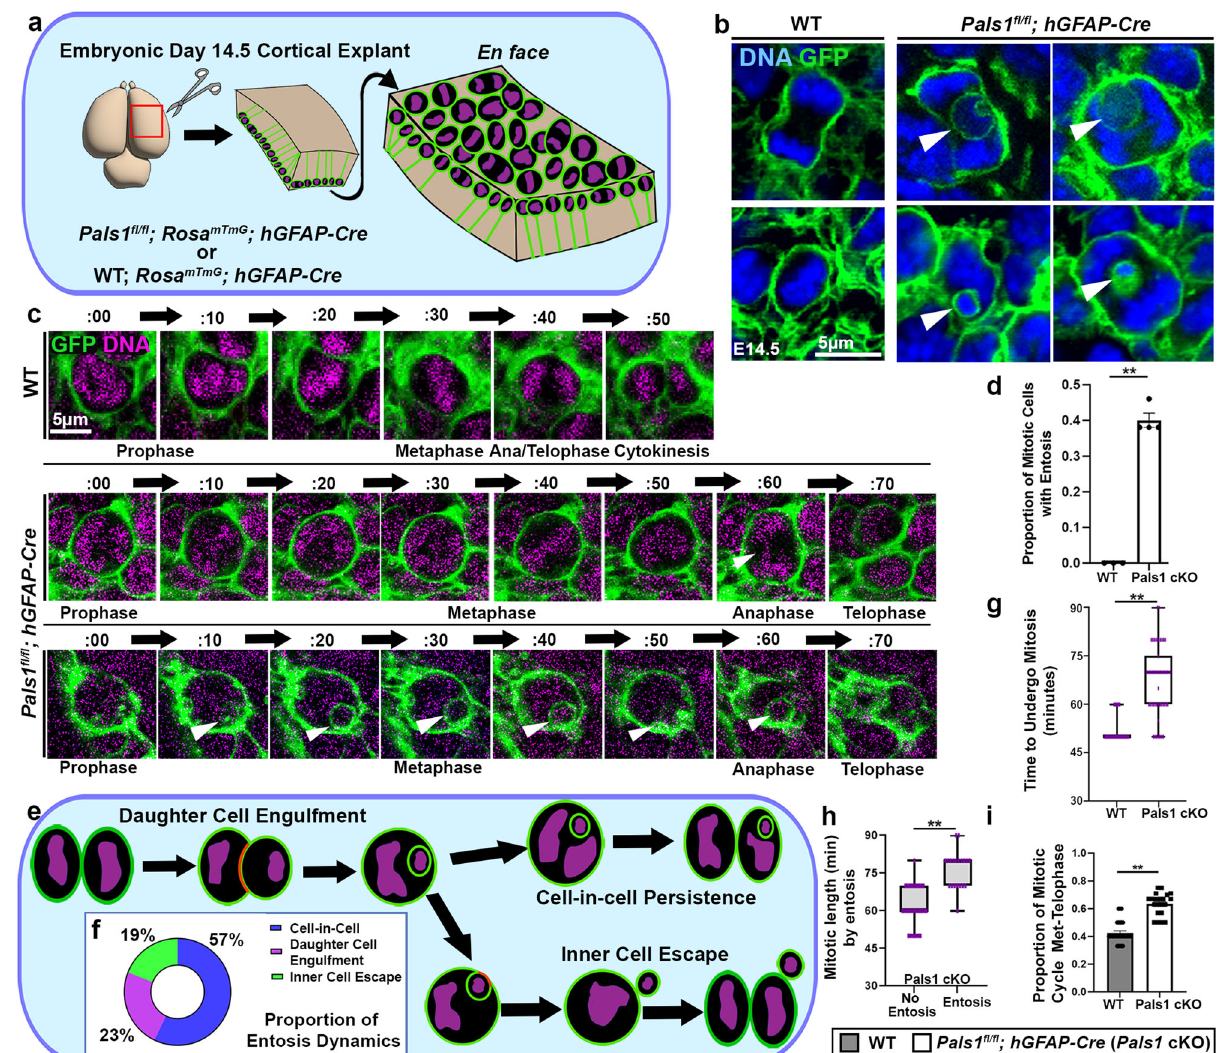
Fig.1| Pals1 deletioncausescell-in-cell(CIC)structuresincorticalprogenitors. a A schematic depicting the method for cortical explant and en face apical surface imaging. b Representative static images taken from apical surface imaging atE14.5 immunostainedforGFPtolabelcellmembranesindividingneuralprogenitors.CIC structures are indicated by white arrows. Images are from experiments including WT n =3 brains, Pals1 fl / fl ; hGFAP-Cre n =4 brains, 20 cells per brain. c Time-lapse imaging, undertaken at 10-min intervals of WT and Pals1 fl / fl ; hGFAP-Cre progenitors atE14.5 visualizedfor membrane GFP and SiR-DNA atthe apicalsurface. Persistent CIC structures and lagging chromosomes are indicated by white arrows. d Quanti fi cation of the proportion of total mitotic cells that display entotic struc- tures at E14.5 (WT n =3 brains, Pals1 fl / fl ; hGFAP-Cre n =4 brains, 20 cells per brain, P =<0.0001). e A schematic depicting the possible dynamics of entosis in apical progenitors. f Quanti fi cation of the proportion of Pals1 fl / fl ; hGFAP-Cre cells